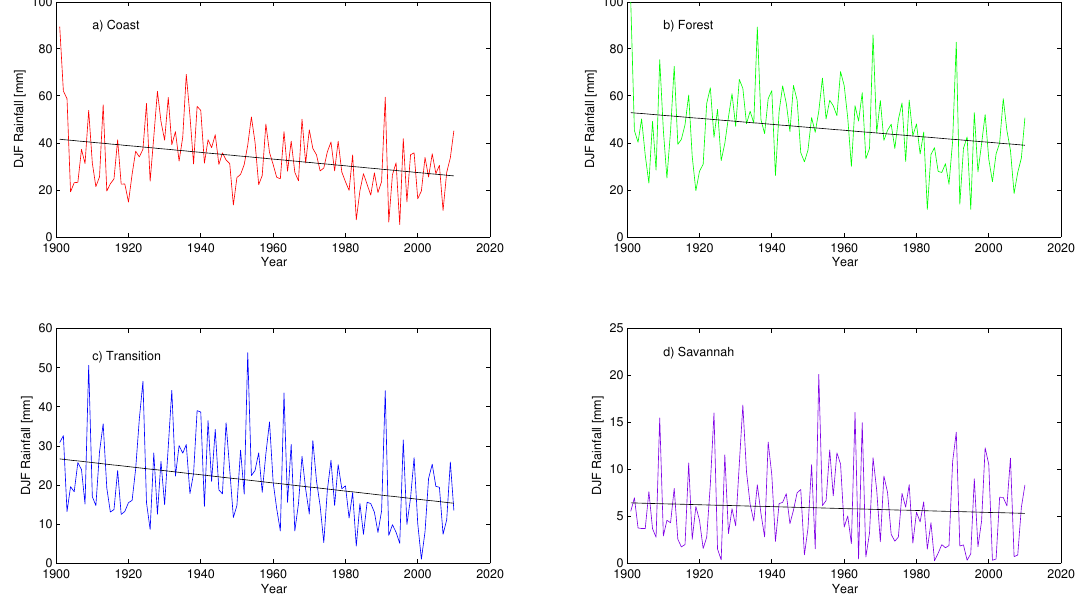
Figure 13. ( a – d ) Long-term course of seasonal rainfall over the agro-ecological zones of Ghana for